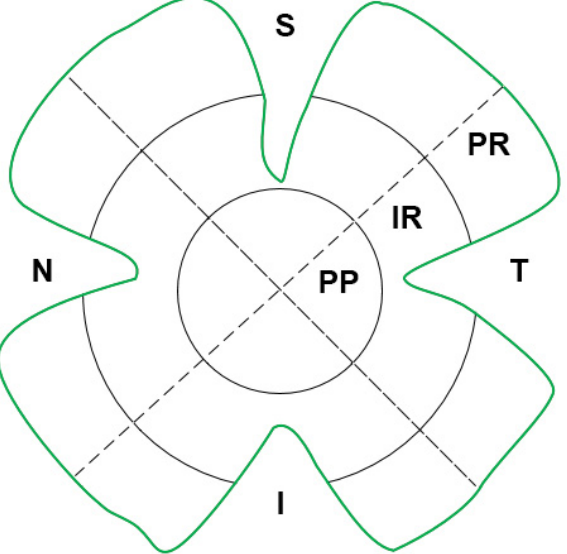
Figure 7. Schematic representation of the areas: superior (S), inferior (I), nasal (N) and temporal (T); and zones: peripapillary (PP), intermediate (IR) and peripheral (PR), into which the retina has been divided for study.